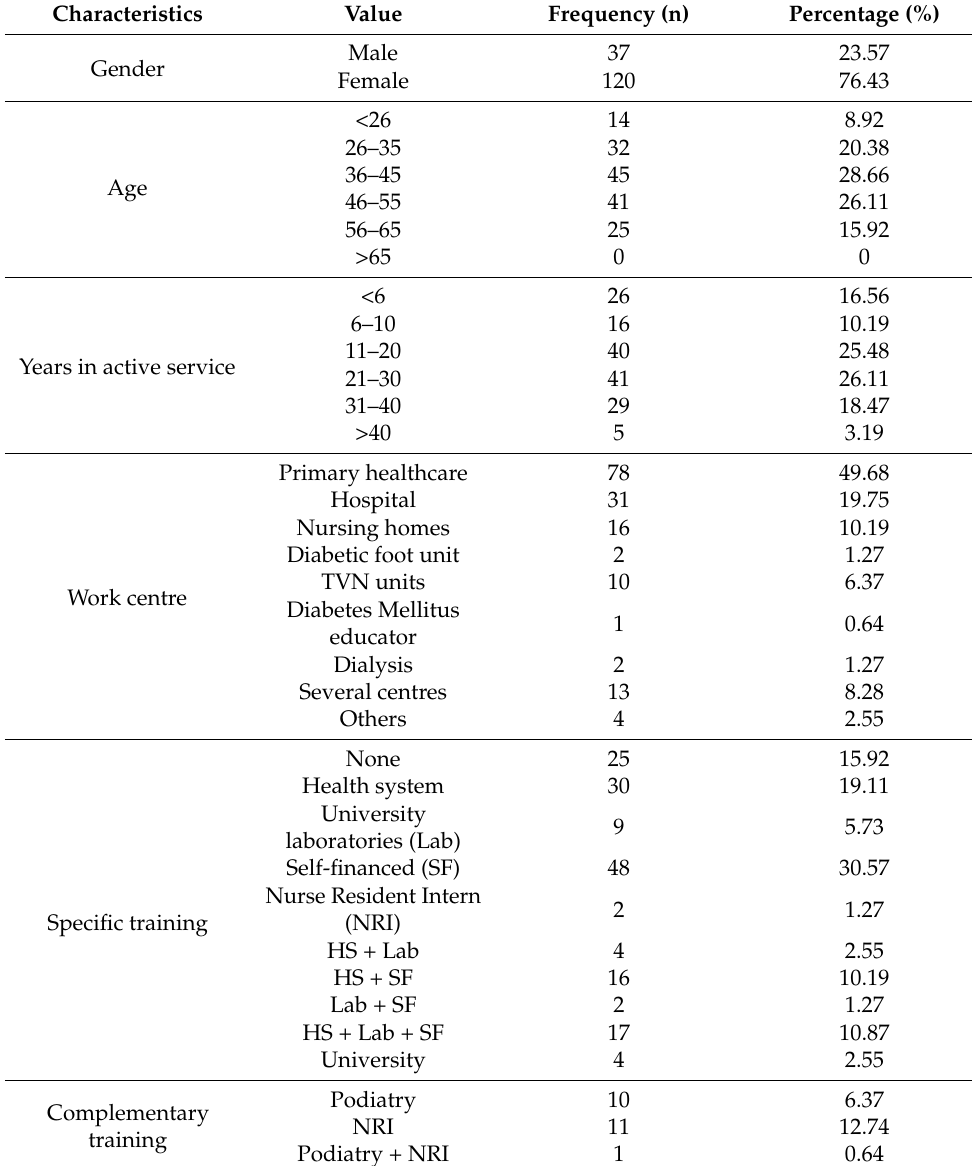
Table 1. Distribution of nurses according to sociodemographic characteristics. (n =